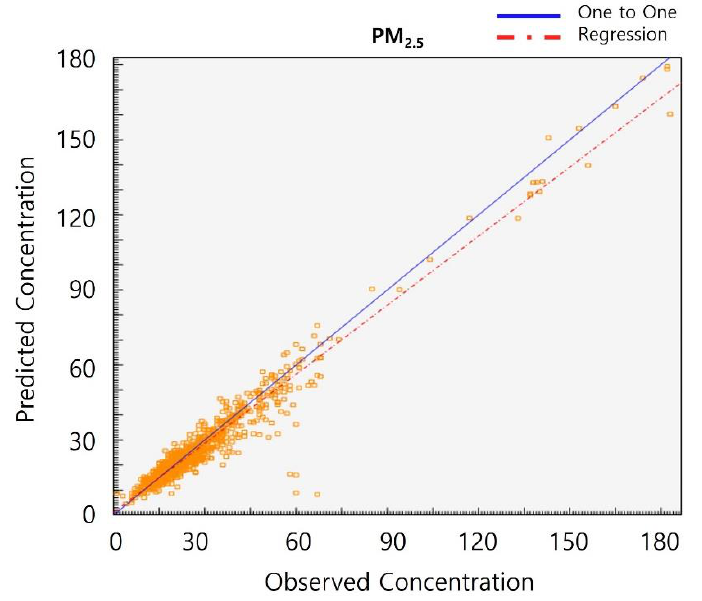
Figure 4. Factor contributions in Daejeon .